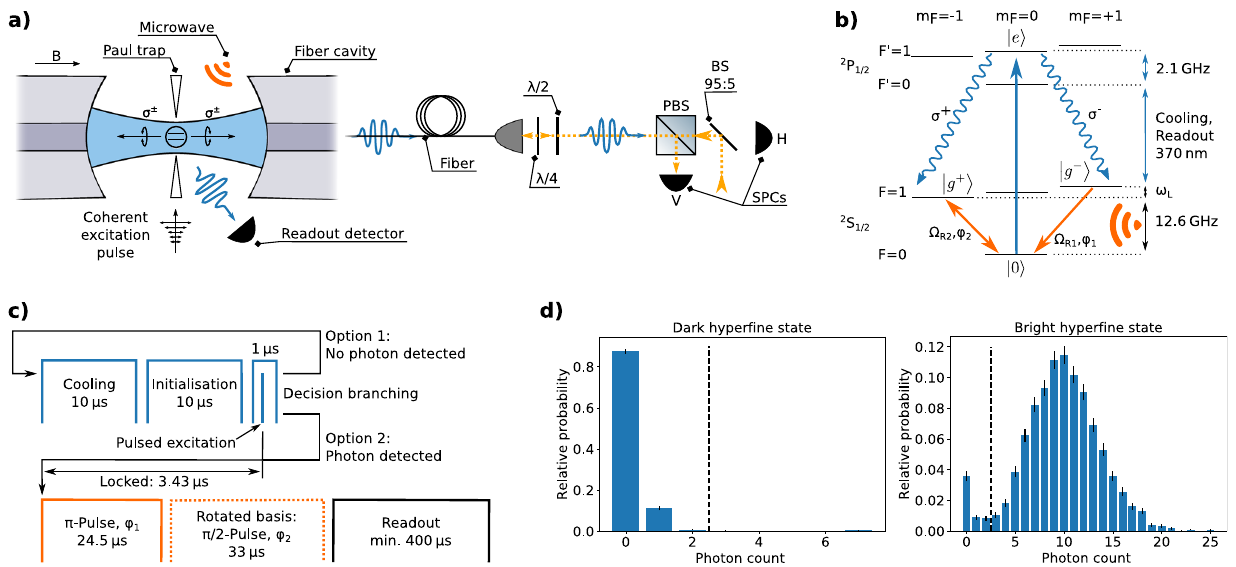
Fig. 1 Experimental setup. a We collect the single emitted photons along the quantization axis with a fi ber Fabry – Perot cavity and analyze them using a projective measurement of polarization. b Selected energy levels of 171 Yb + including the relevant optical transitions. After pulsed excitation from the 0 j i to the e j i state, the ion decays in a superposition of decay channels emitting a σ ± polarized photon. Subsequent manipulation of the atomic qubit is done via microwave pulses. c Experimental sequence for creating and verifying atom-photon entanglement including decision branching, see main text for explanation. d Readout of the hyper fi ne qubit using discrimination between dark and bright hyper fi ne states. In σ z ⊗ σ z basis we achieve a readout fi delity of 98.2(6)% using the dashed line as bright/dark threshold for a readout window length of 400 μ s (see, methods for details). Error bars show the standard